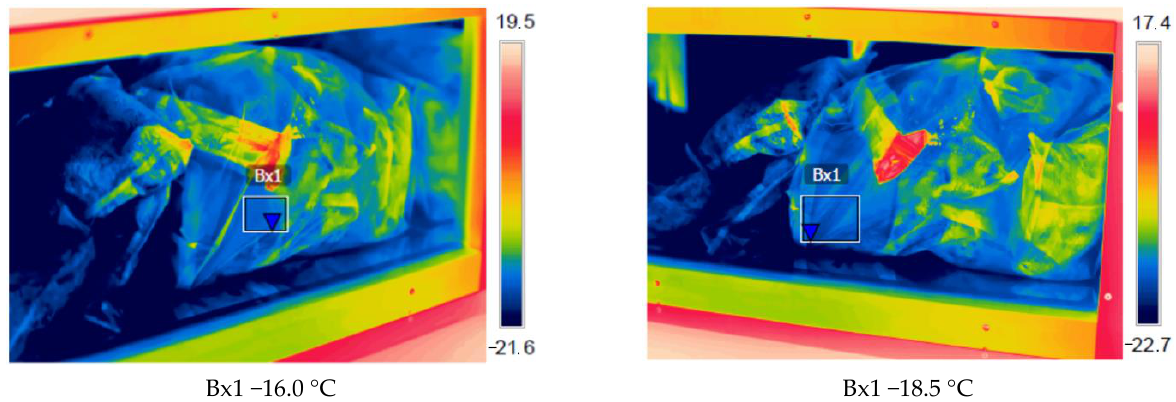
Figure 9. Thermograms for the filled chamber 2 of the freezing module immediately after storage .